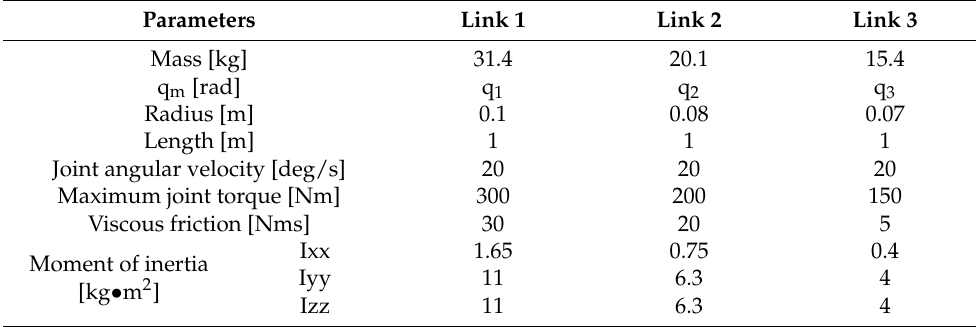
Table 2. Main parameters of manipulator with 3-DOF links. Parameters